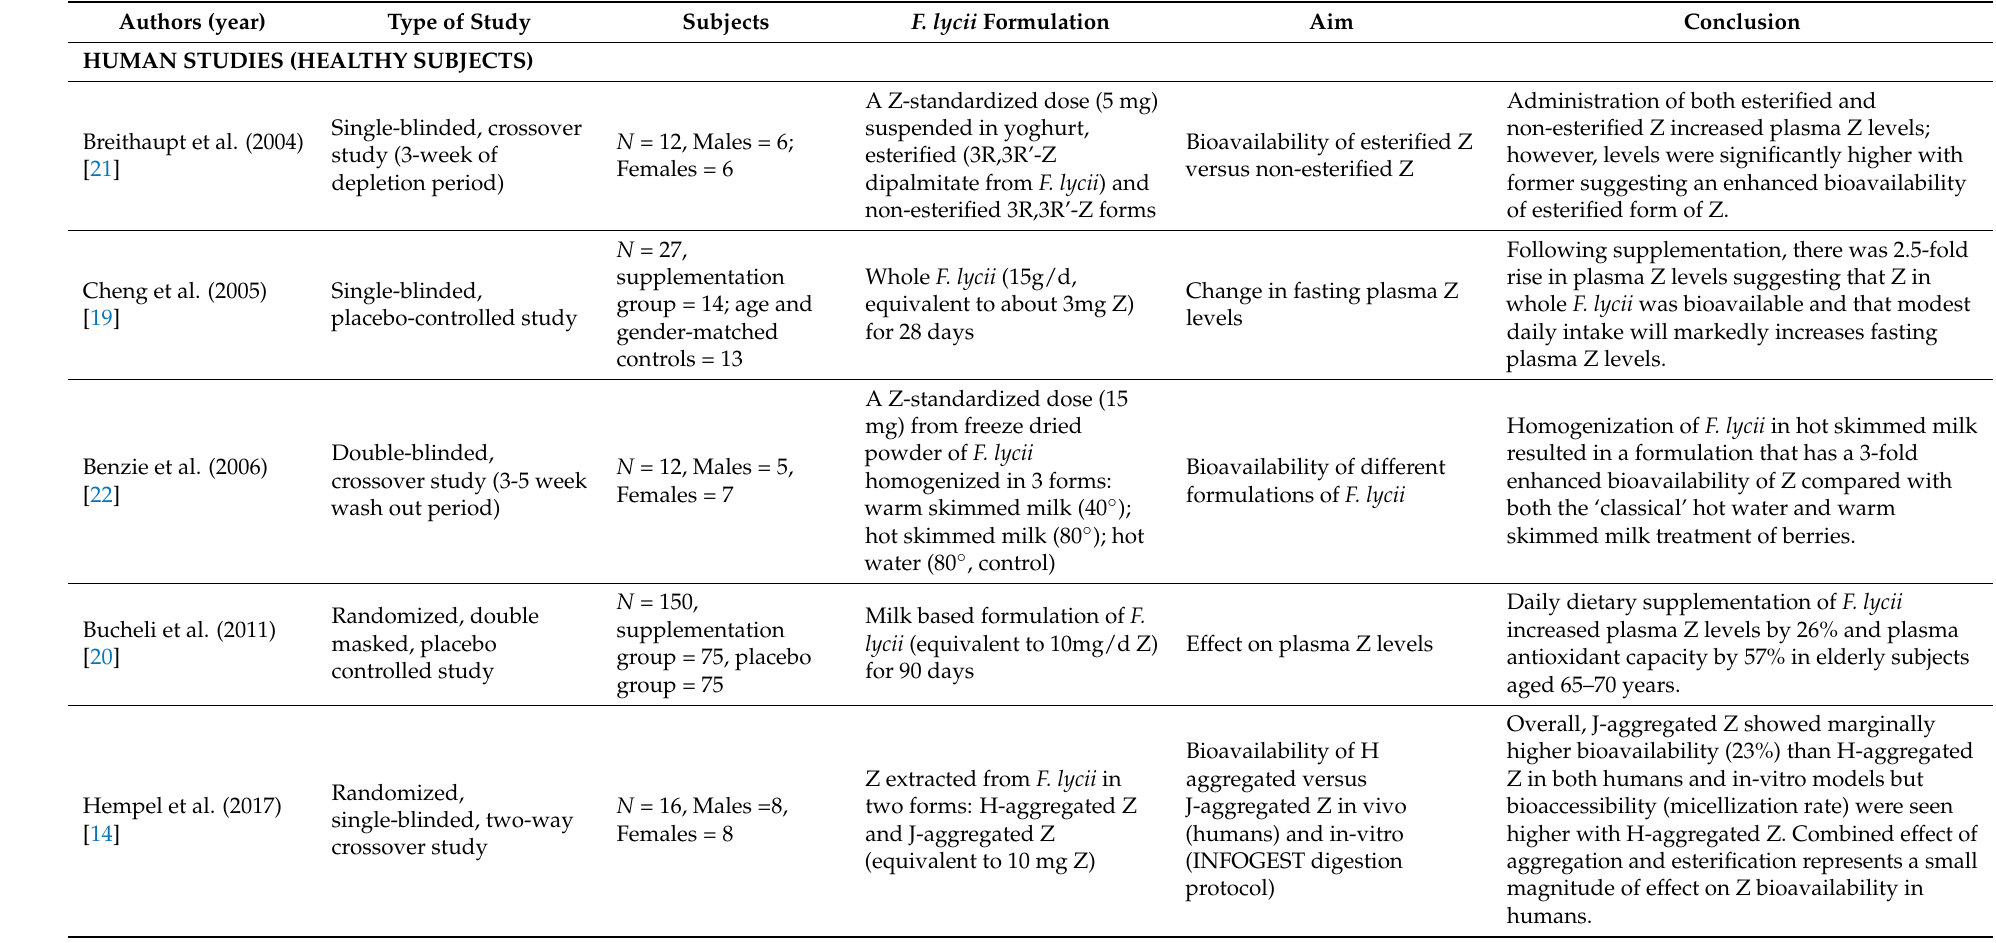
Table 1. List of studies examining the bioavailability of carotenoid zeaxanthin in Fructus lycii